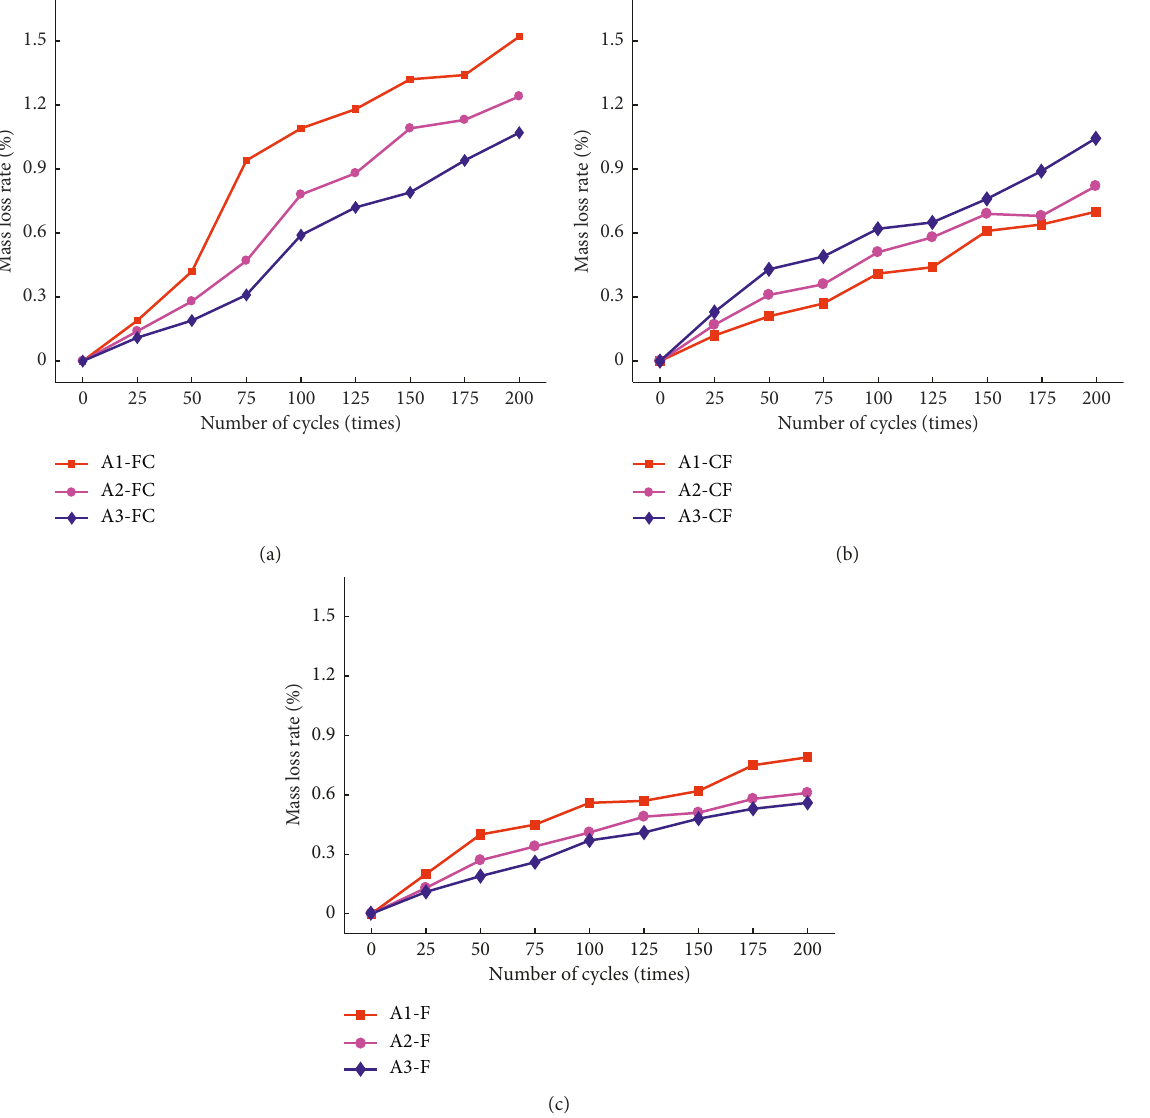
Figure 4: Mass loss rates of A1, A2, and A3 with different testing modes: (a) FC mode; (b) CF mode; (c) F